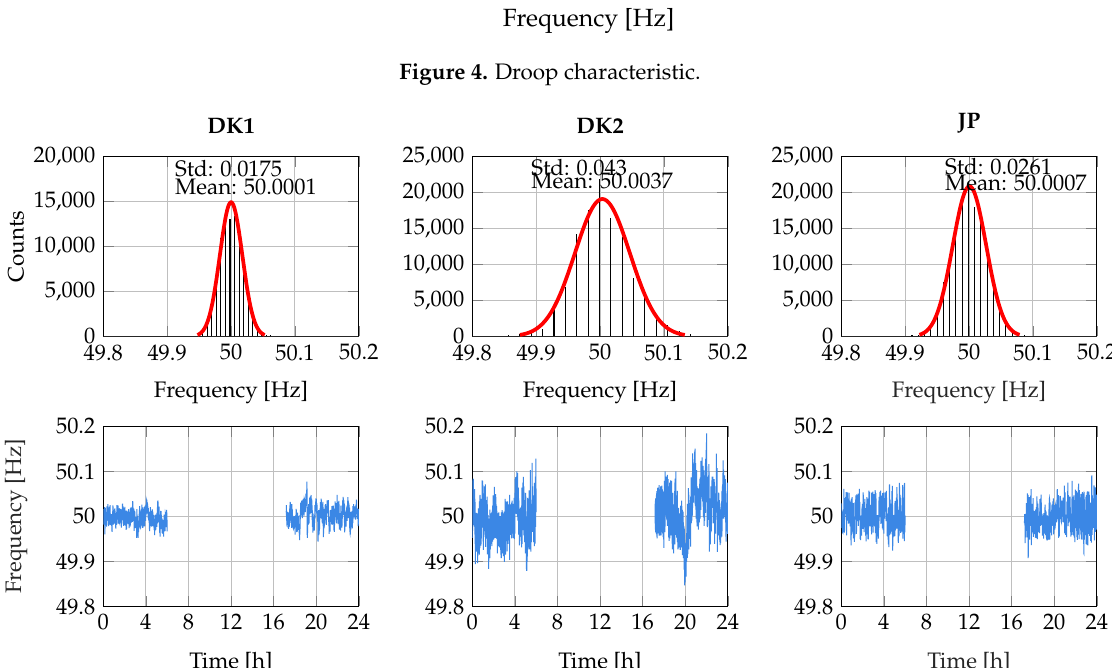
Figure 5. Frequency histogram fitted in Gaussian distribution and frequency trend during the 13 h of FR service provision in DK1, DK2 and Japan.